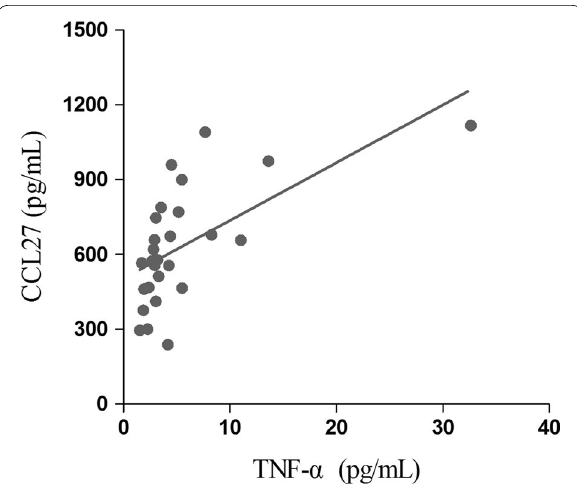
Fig. 3 Positive correlation between serum CCL27 and TNF‑α levels in patients with SJS/TEN, during the acute stage of disease ( r s P < 0.001). Statistical significance was determined by Spearman rank correlation test Fig. 4 CCL27 levels in serum and blister fluid of patients with SJS/